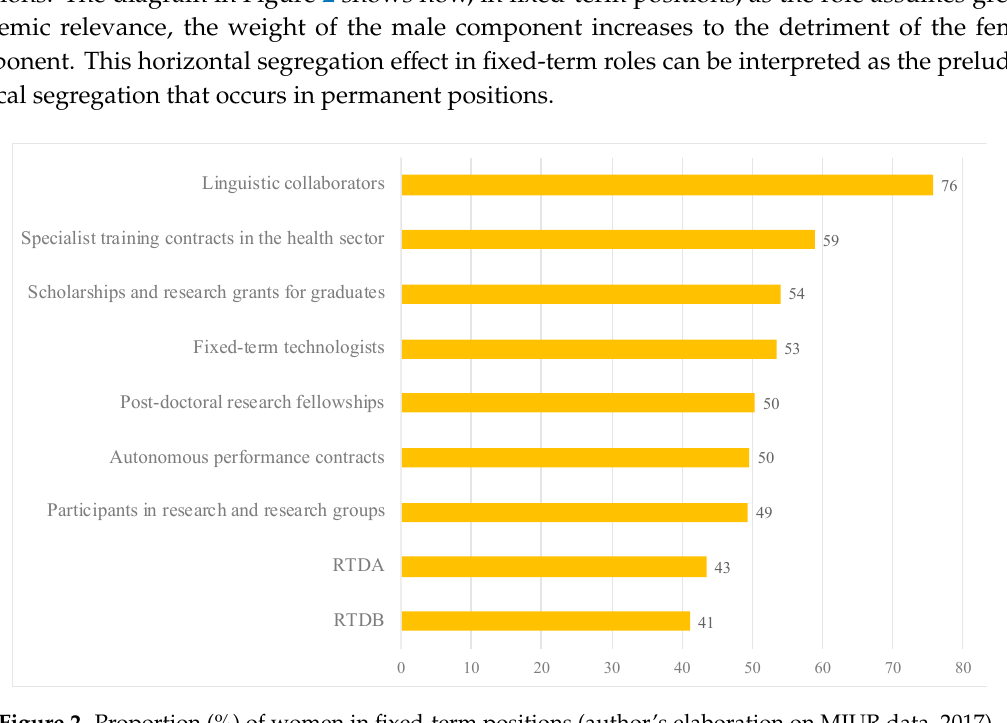
Figure 2. Proportion (%) of women in fixed-term positions (author’s elaboration on MIUR data, 2017).